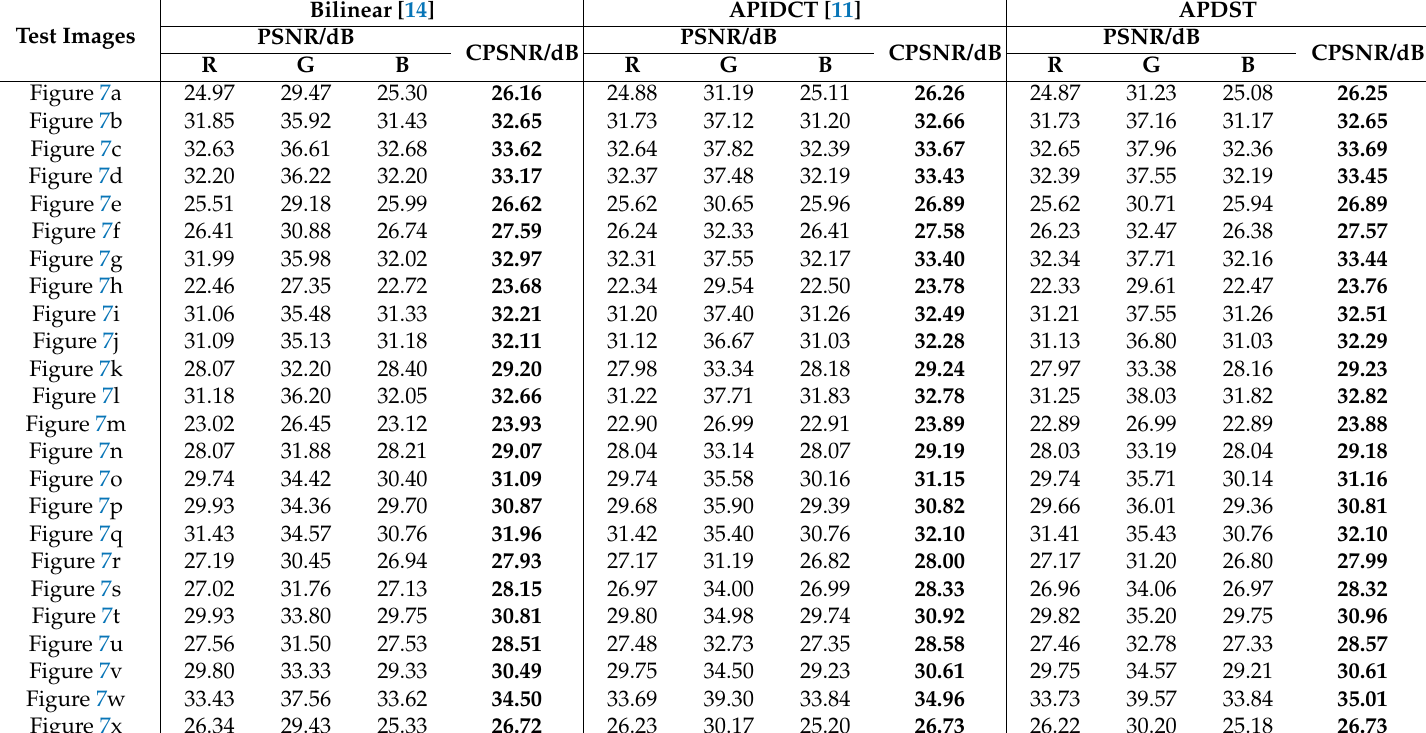
Table 1. Comparisons of PSNR and CPSNR among bilinear interpolation [14], APIDCT interpolation [11], and APDST interpolation of Kodak images with a size of 512 × 768 or 768 × 512 in PNG